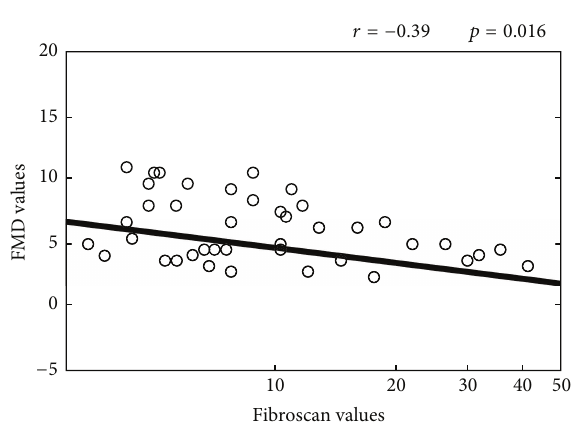
Figure 1: Correlation between FMD and fibroscan